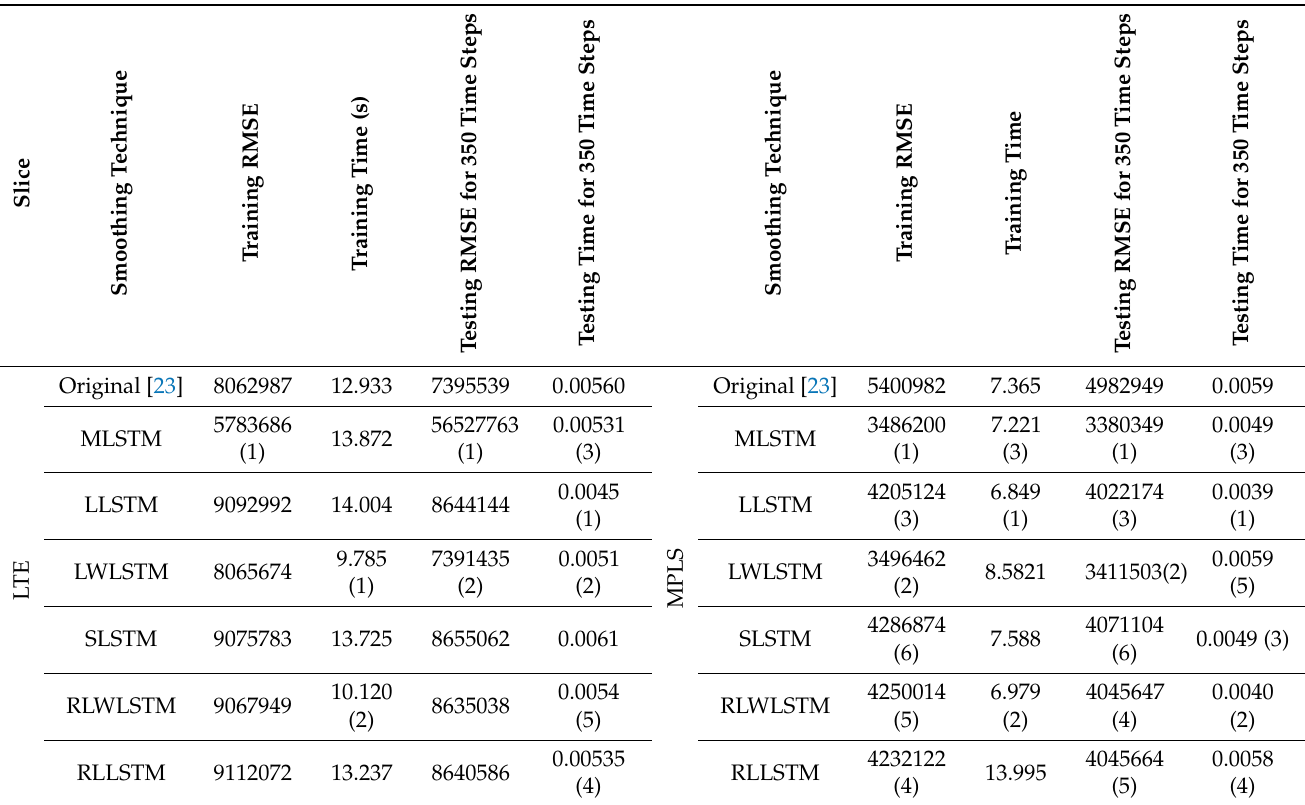
Table 6. Performance of combining local smoothing and